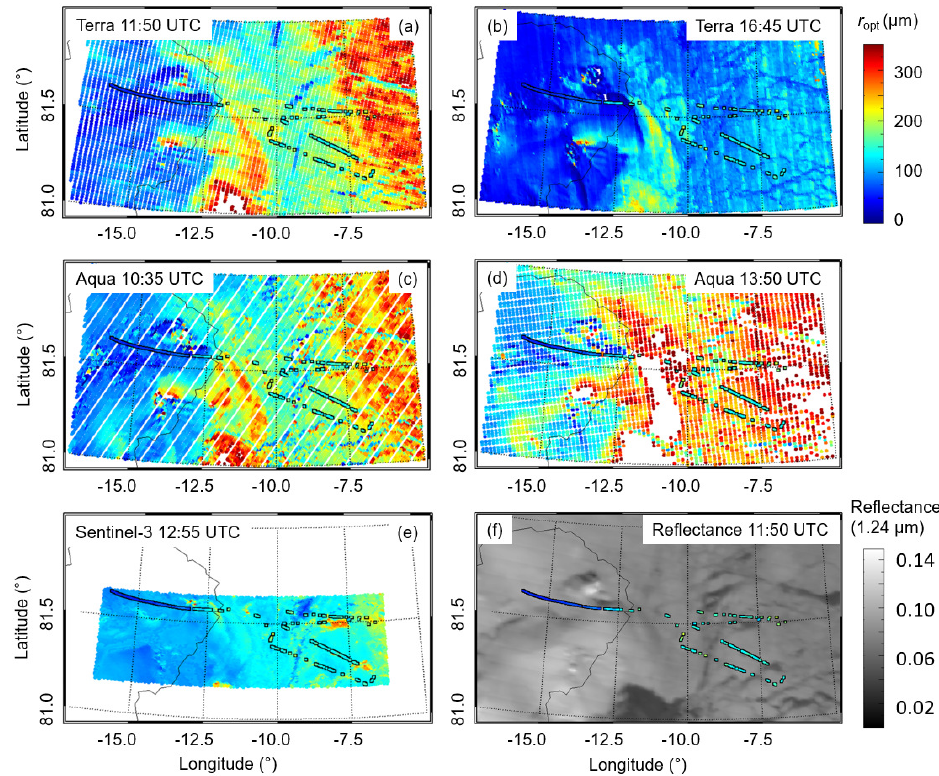
Figure 6. Snow grain size estimated from MODIS satellite observations and applying the SGSP retrieval ( a – d ), and XBAER retrieval results on SLSTR data ( e ) for the area overflown with the Polar 5 aircraft on 25 March 2018. ( f ) MODIS reflectance (MOD02) measured at 1.24 µm wavelength. The colour-coded r opt derived from SMART measurements ( α (1700 nm)-based method) is